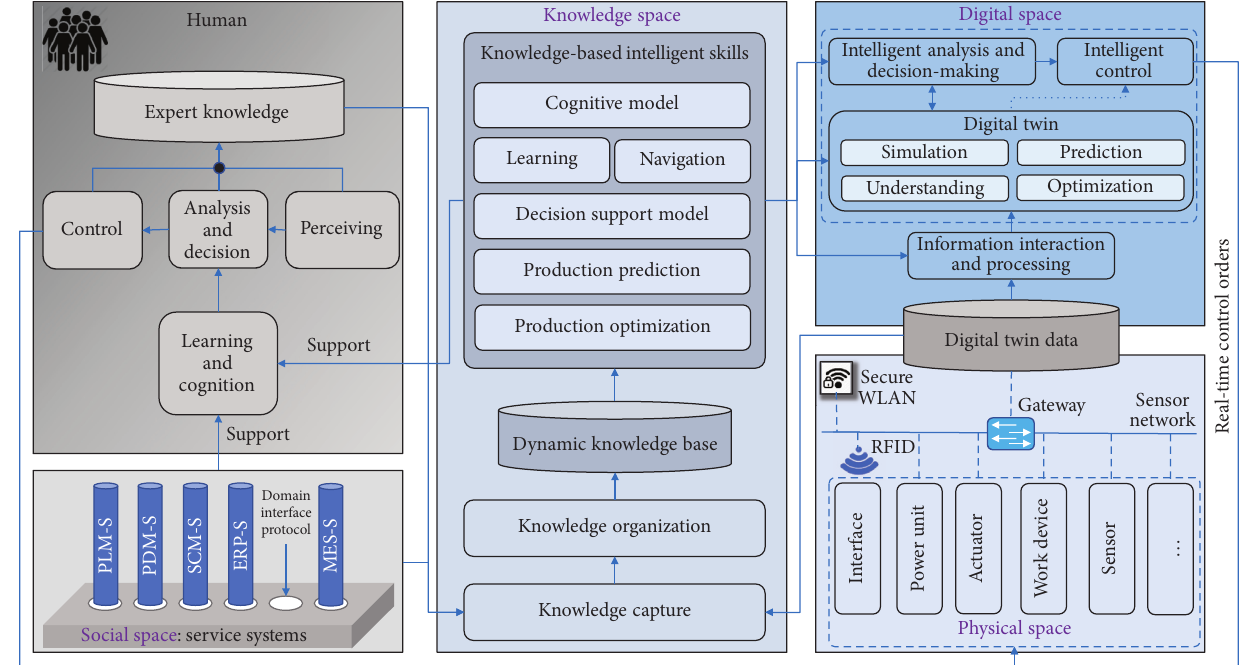
Figure 9: Architecture of knowledge-based digital twin solutions. The digital world and humans can collaboratively control the physical space and the knowledge space that supports it. The experiences are also saved and, therefore,